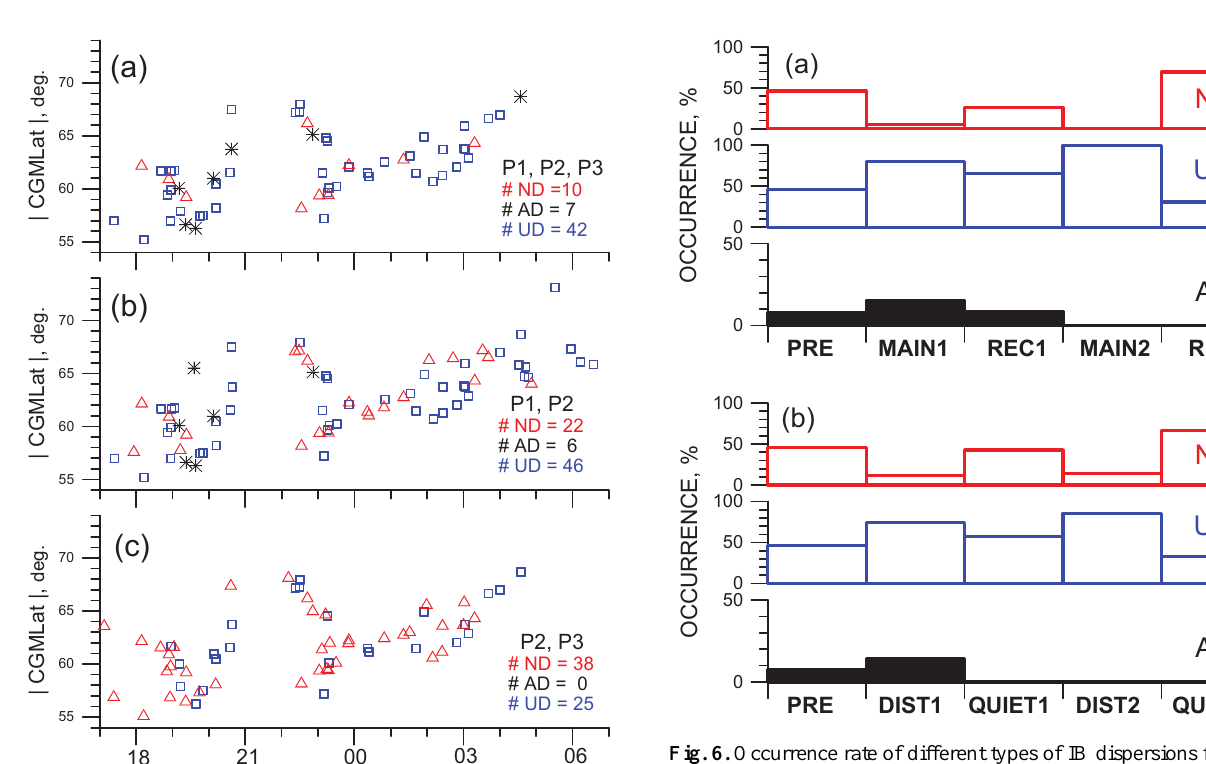
Fig. 6. Occurrence rate of different types of IB dispersions for spe- cific phases of the storm: (a) phases defined according to Sym-H ∗ , (b) phases defined according to the AL